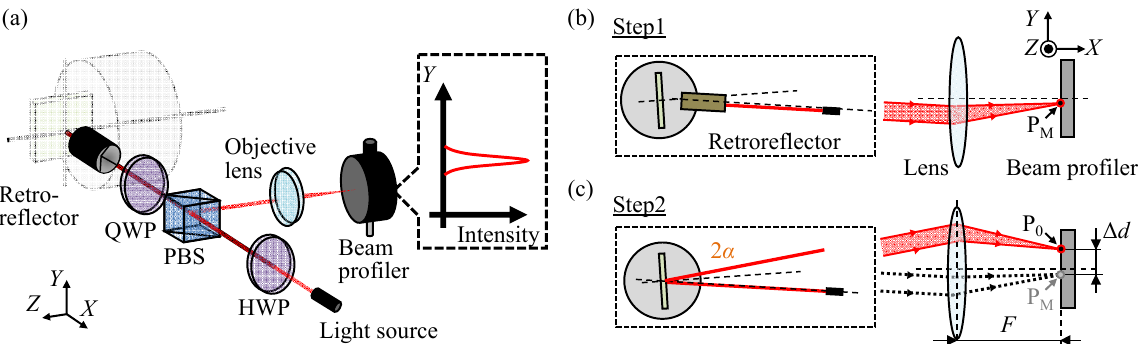
Figure 7. Alignment of the measurement laser beam by using a retroreflector and a beam profiler: ( a ) Setup with a retroreflector; ( b , c ) Procedure of the alignment.